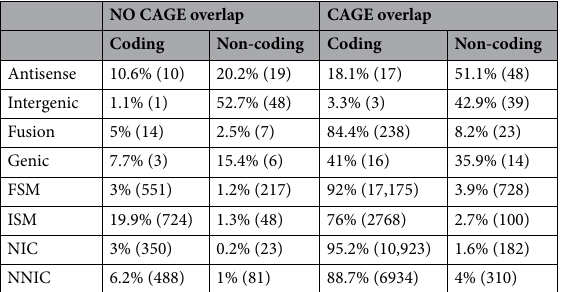
Table 1. CAGE overlap and coding prediction of the novel transcripts break down into the eight categories. For each row, the proportions and the corresponding counts of each category are shown.